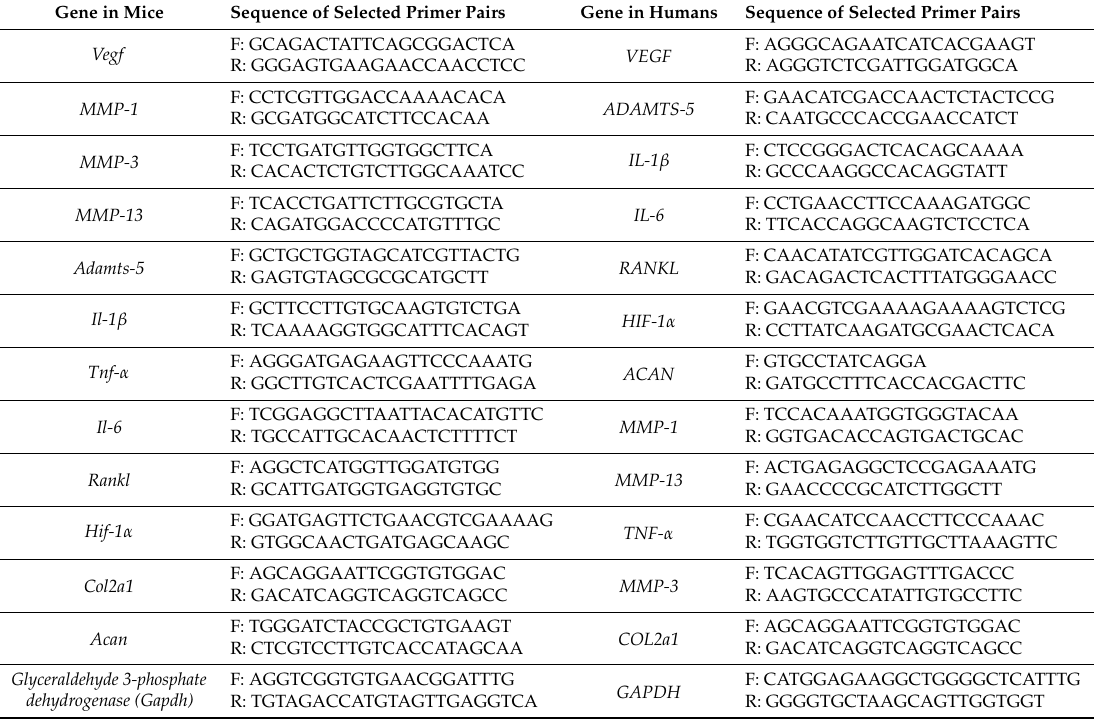
Table 2. Primer sequences used for real-time